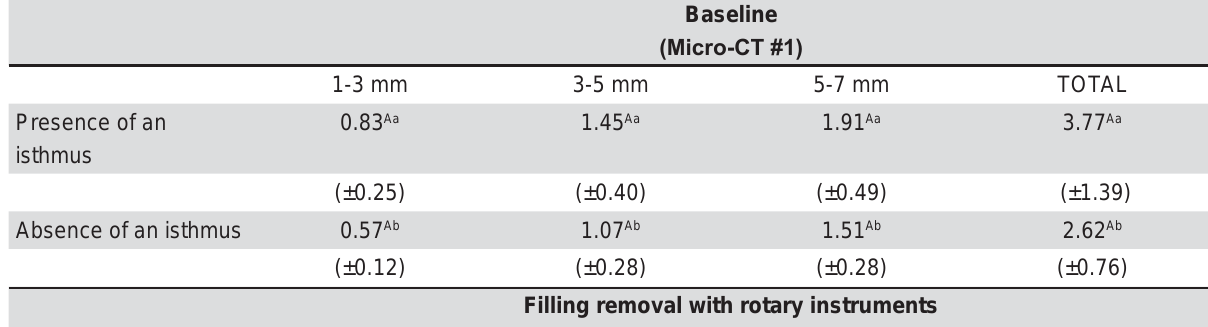
Table 2- (cid:3)(cid:48)(cid:72)(cid:68)(cid:81)(cid:3)(cid:68)(cid:81)(cid:71)(cid:3)(cid:86)(cid:87)(cid:68)(cid:81)(cid:71)(cid:68)(cid:85)(cid:71)(cid:3)(cid:71)(cid:72)(cid:89)(cid:76)(cid:68)(cid:87)(cid:76)(cid:82)(cid:81)(cid:3)(cid:82)(cid:73)(cid:3)(cid:87)(cid:75)(cid:72)(cid:3)(cid:89)(cid:82)(cid:79)(cid:88)(cid:80)(cid:72)(cid:3)(cid:82)(cid:73)(cid:3)(cid:191)(cid:79)(cid:79)(cid:76)(cid:81)(cid:74)(cid:3)(cid:80)(cid:68)(cid:87)(cid:72)(cid:85)(cid:76)(cid:68)(cid:79)(cid:3)(cid:68)(cid:87)(cid:3)(cid:69)(cid:68)(cid:86)(cid:72)(cid:79)(cid:76)(cid:81)(cid:72)(cid:15)(cid:3)(cid:68)(cid:73)(cid:87)(cid:72)(cid:85)(cid:3)(cid:191)(cid:79)(cid:79)(cid:76)(cid:81)(cid:74)(cid:3)(cid:85)(cid:72)(cid:80)(cid:82)(cid:89)(cid:68)(cid:79)(cid:3)(cid:90)(cid:76)(cid:87)(cid:75)(cid:3)(cid:85)(cid:82)(cid:87)(cid:68)(cid:85)(cid:92)(cid:3)(cid:76)(cid:81)(cid:86)(cid:87)(cid:85)(cid:88)(cid:80)(cid:72)(cid:81)(cid:87)(cid:86)(cid:15)(cid:3) and after re-preparation taking into consideration the presence or absence of an isthmus in the mesial root of mandibular molar